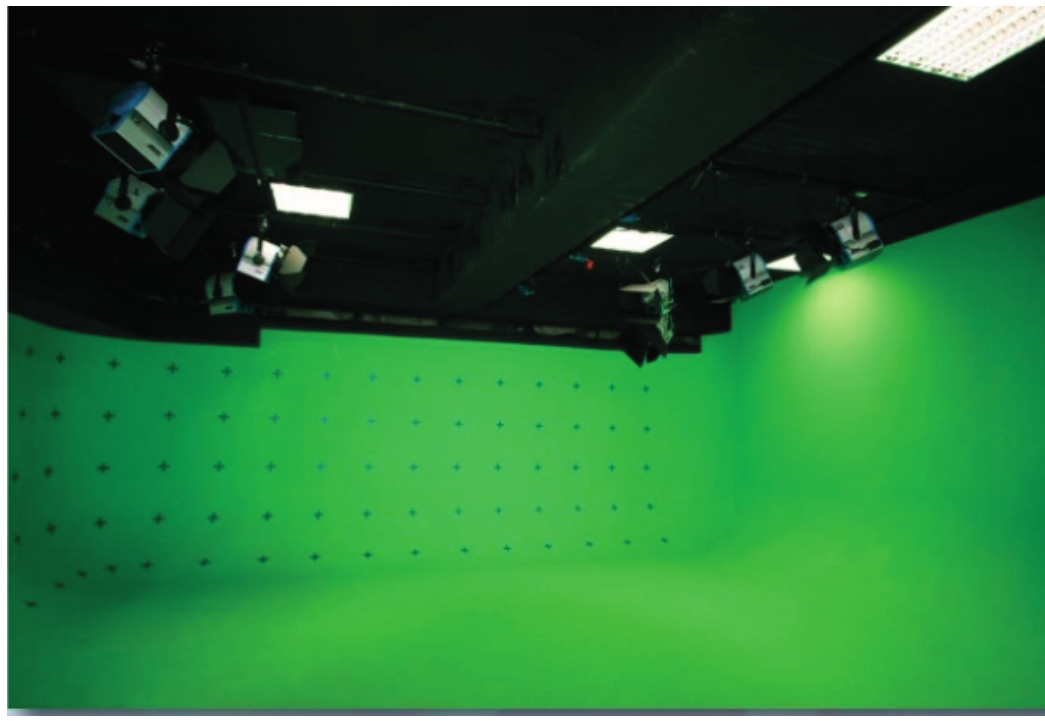
Figure 5. Recording